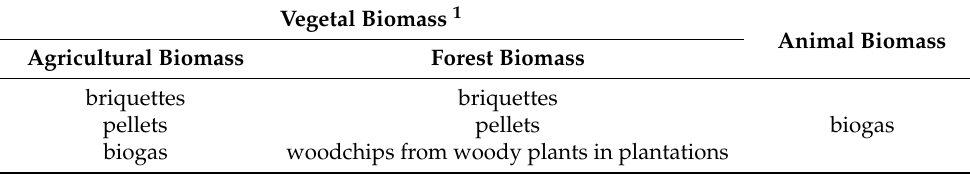
Table 2. Biomass combustion